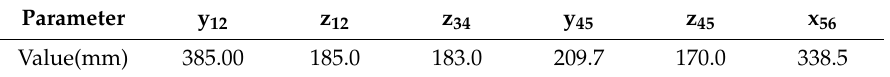
Table 2. The relative position parameters of the origin of each coordinate system (mm).